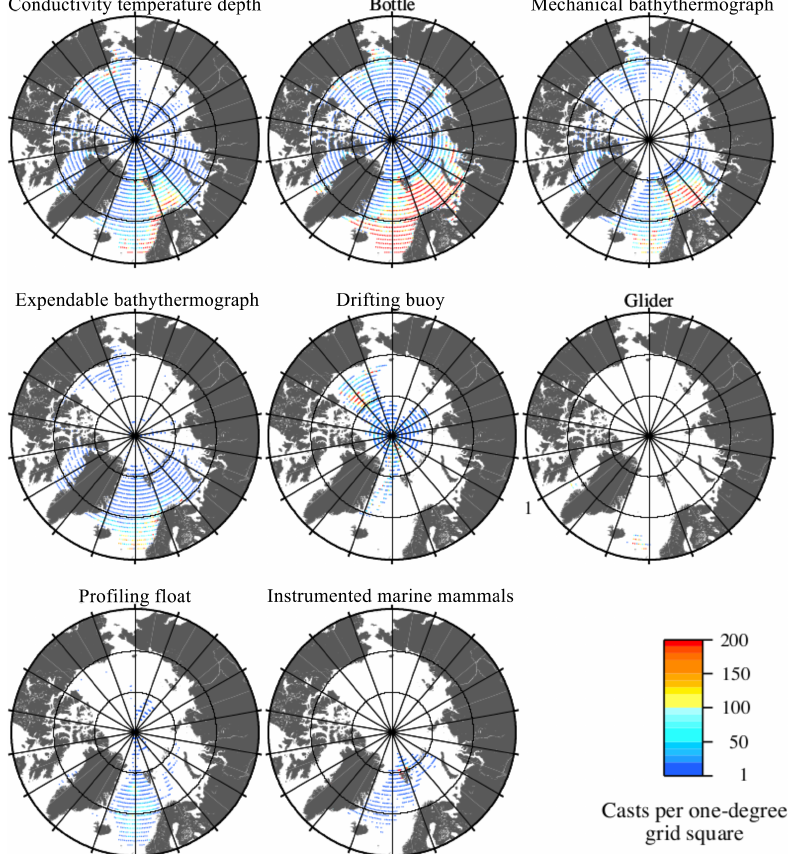
Figure 6. Data distribution by instrument. Areas left white indicate no data.